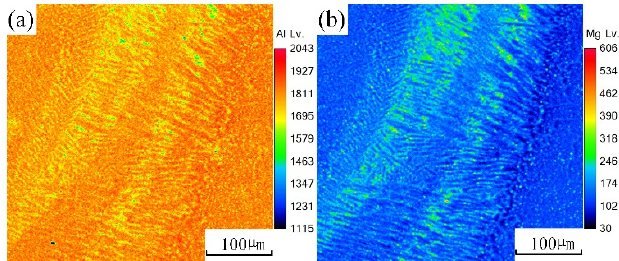
Figure 11. The sweep diagrams of different elements in the in-air cladding layer: ( a ) Al; ( b ) Mg.